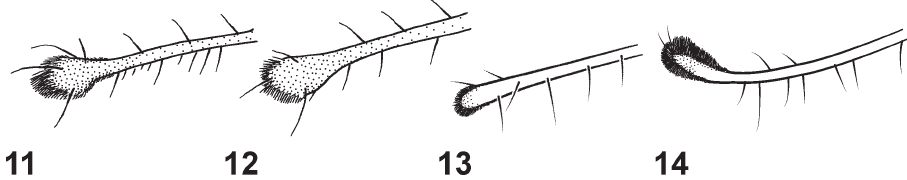
Figures 11–14. Coenosia spp. palpi 11 C. flagelliseta sp. nov. ♂ 12 C. flagelliseta sp. nov. ♀ 13 C. mac- rotriseta ♂ 14 C. globuliseta ♂ . Figs 13, 14 reused (Muller and Miller 2013, figs